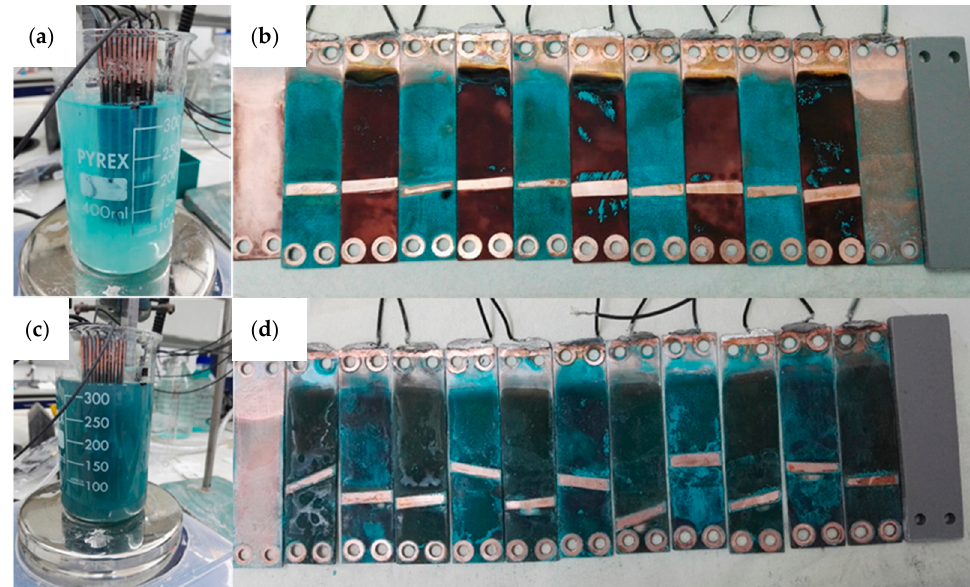
Figure 3. Picture of the test cell and electrodes after synthesis. ( a , b ) were used for DC electrosynthesis, whereas ( c , d ) used 0.250 Hz polarity reversal. Strips on electrode surfaces without product deposition are from the use of spacers to control the inter-electrode distances.